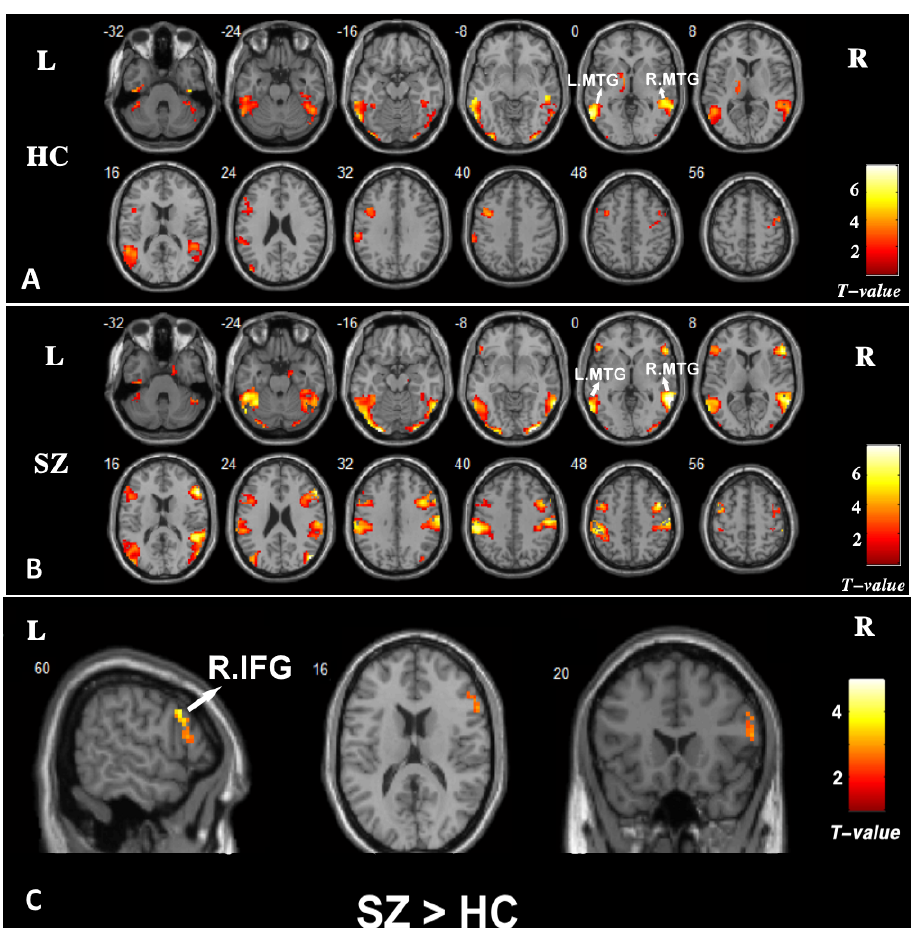
Figure 3. Brain activation patterns in the groups of ( A ) healthy controls (HC) and ( B ) schizophrenia (SZ) at the condition of ToM > random. Threshold at p < 0.05, FDR-corrected for multiple comparisons and cluster extent > 50 voxels. ( C ) Between-group brain activation results at the condition of ToM > random. Threshold at p < 0.005 at the voxel level and p < 0.05 at the cluster level corrected with the AlphaSim correction. Color bars represent T values. MTG, middle temporal gyrus. IFG, inferior frontal